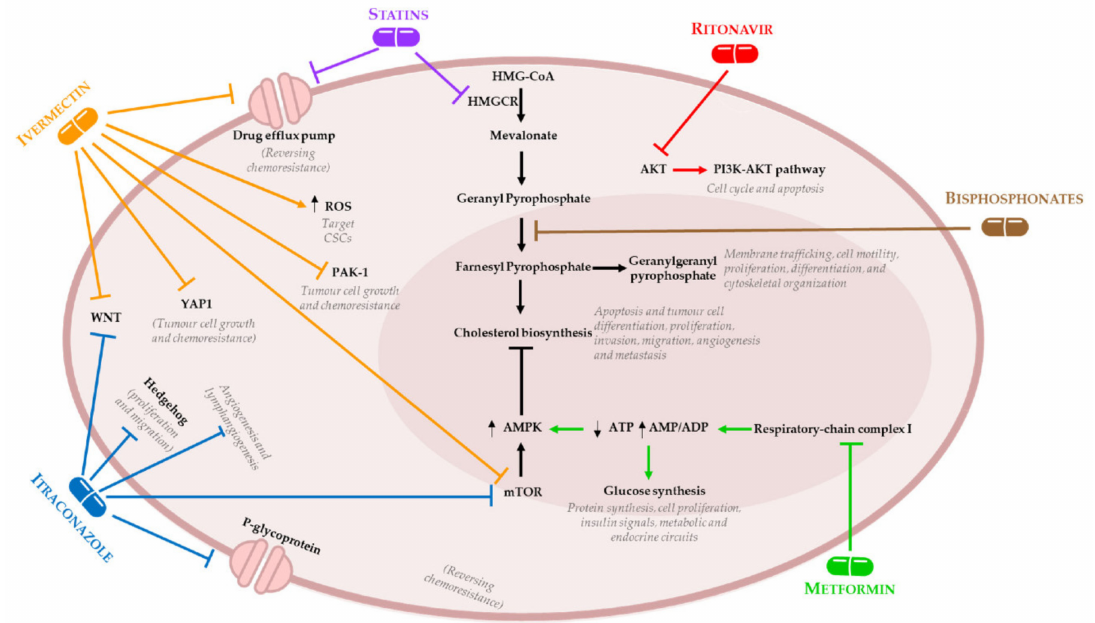
Figure 1. Mechanism of action of non-oncological drugs in ovarian cancer (OC). Statins inhibit 3-hydroxy-3-methylglutaryl-coenzyme A reductase (HMGCR) leading to the blocking of